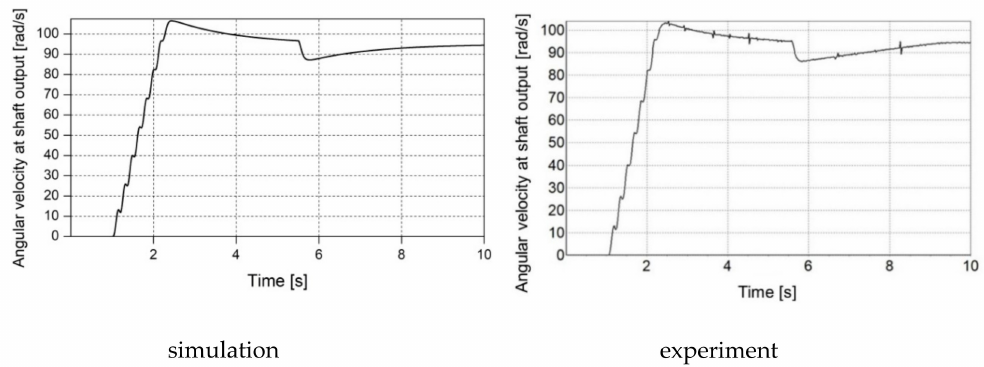
Figure 9. Angular velocity at shaft output vs.